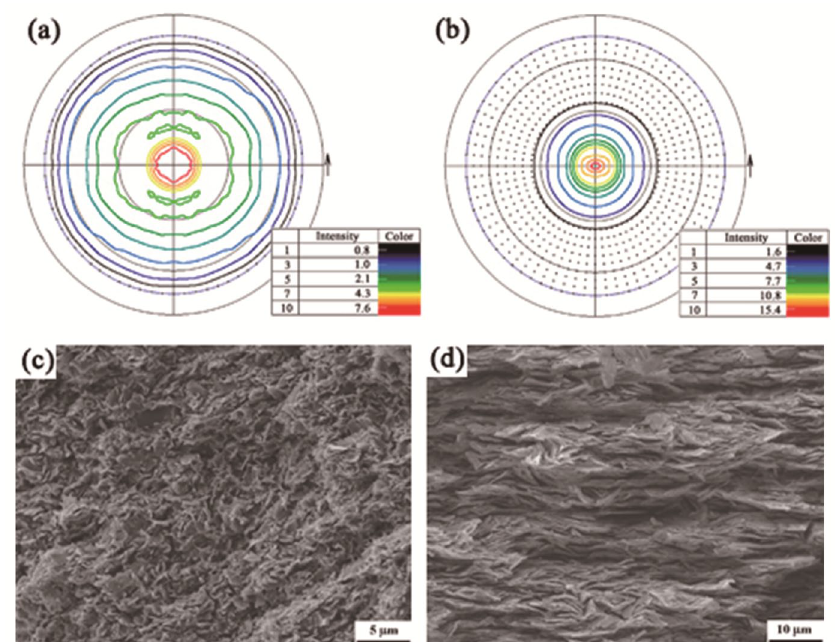
Fig. 6 h-BN (002) pole figures of surfaces perpendicular to the casting direction of green bodies and fracture morphologies of surfaces parallel to the casting direction of sintered specimens prepared using: (a, c) irregular shaped powders; (b, d) plate-like powders. Reproduced with permission from Ref. [79], © The American Ceramic Society